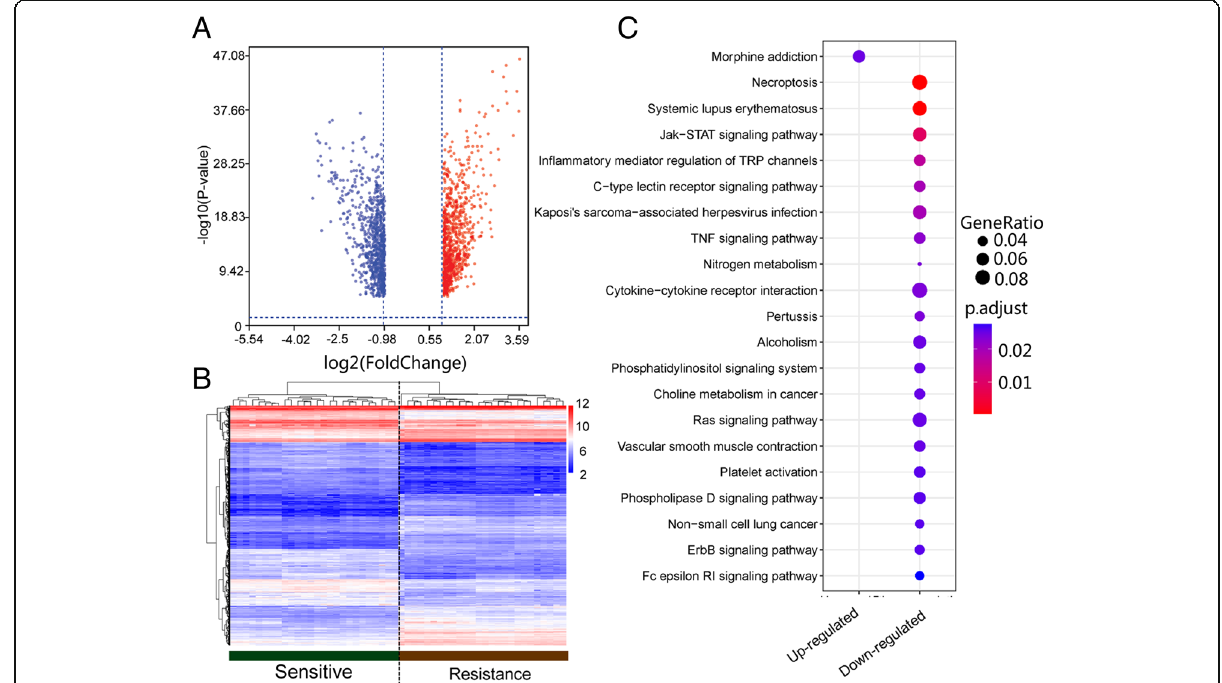
Fig. 3 The information of DEGs and pathway of DEGs. a Volcano plot represents DEGs. b Heatmap of DEGs between sensitive and resistance groups. c KEGG enrichment of